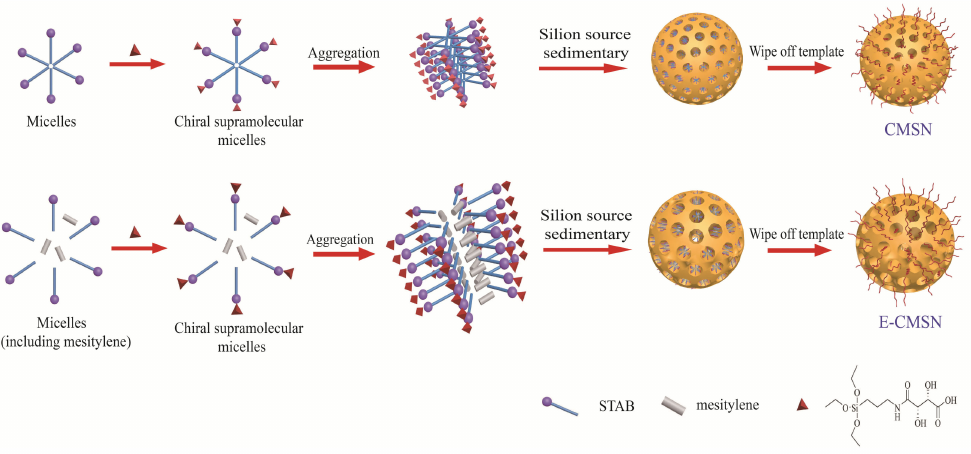
Figure 11. Synthetic routes of CMSN and